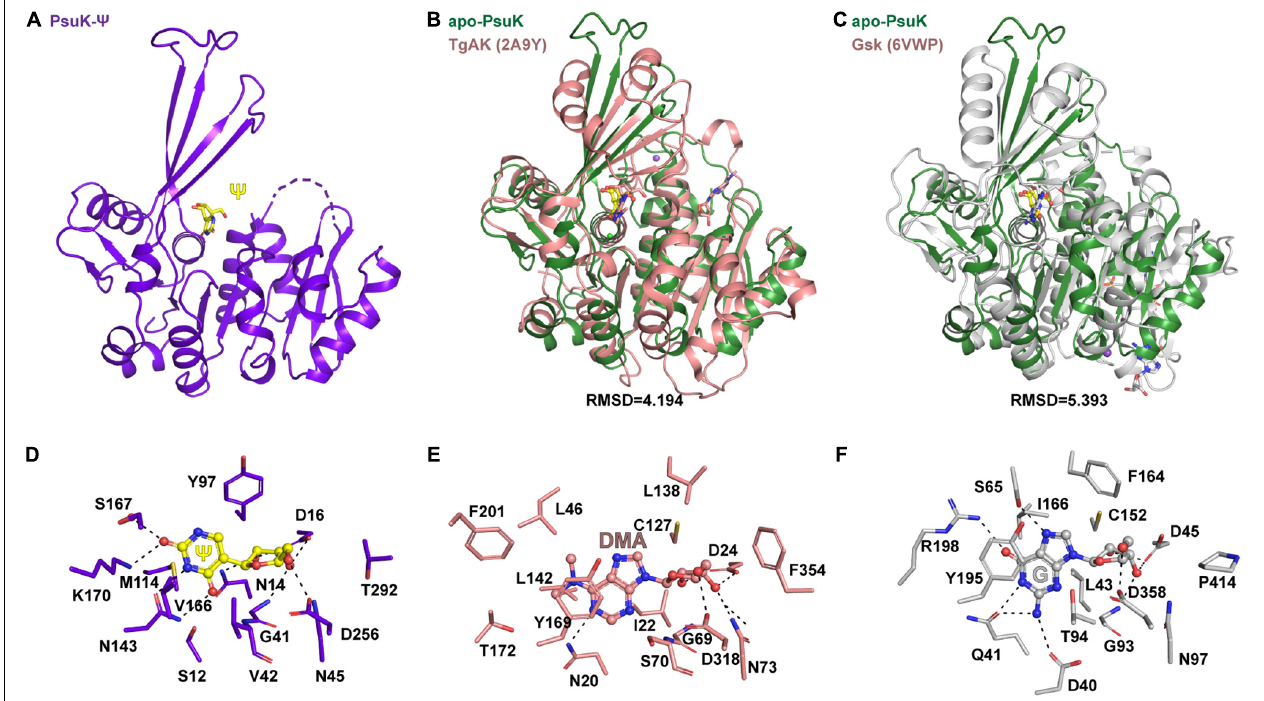
FIGURE 6 | Comparisons of substrate binding properties of Ec PsuK with TgAK and Gsk. (A) The overall structure of Ec PsuK in complex with (cid:57) . (B) Structure superposition of Ec PsuK- (cid:57) with TgAK-DMA complex (PDB code: 2A9Y). The latter complex structure is colored in pink. (C) Structure superposition of Ec PsuK- (cid:57) with Gsk-guanosine complex (PDB code: 6VWP). The latter complex structure is colored in white. (D) Detailed interactions between PusK with (cid:57) . (E) Detailed interactions between TgAK with DMA ( N 6 , N 6 -dimethyladenosine). (F) Detailed interactions between Gsk with